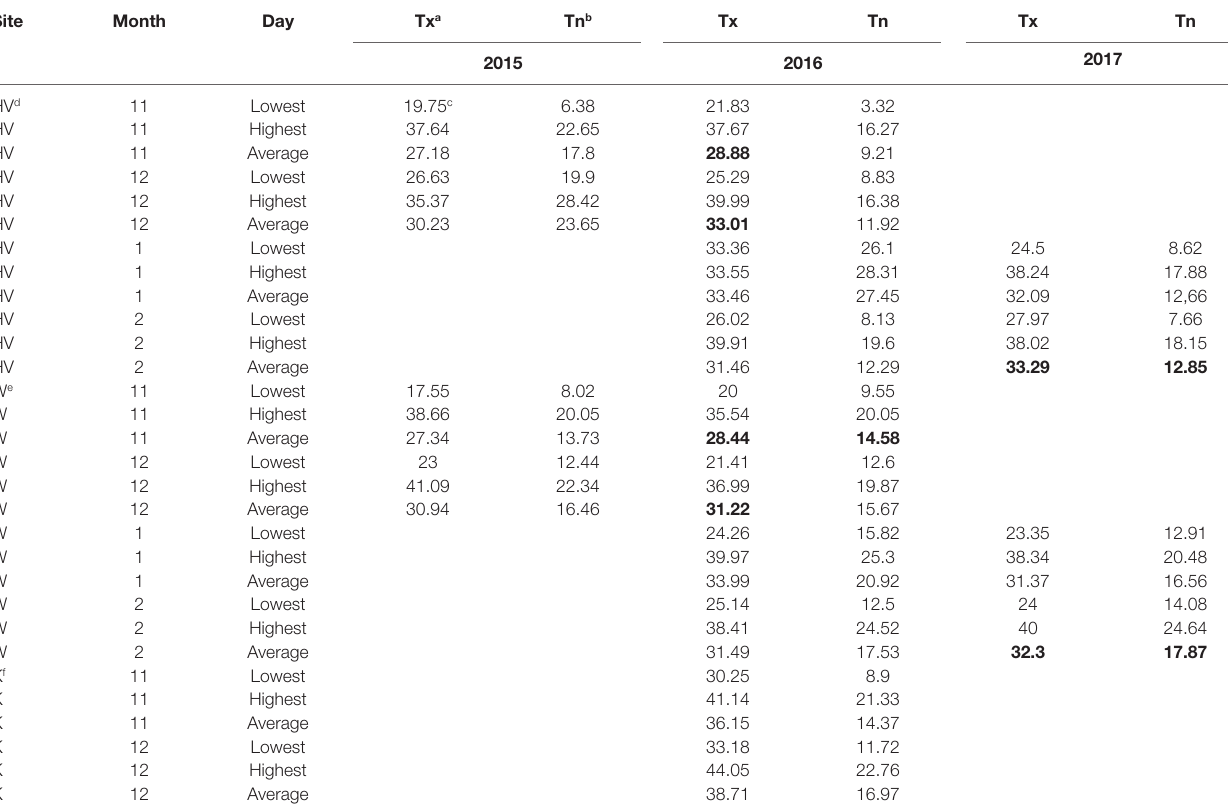
TABle 2 | Temperature data for the sites from which the grapes were harvested. Site